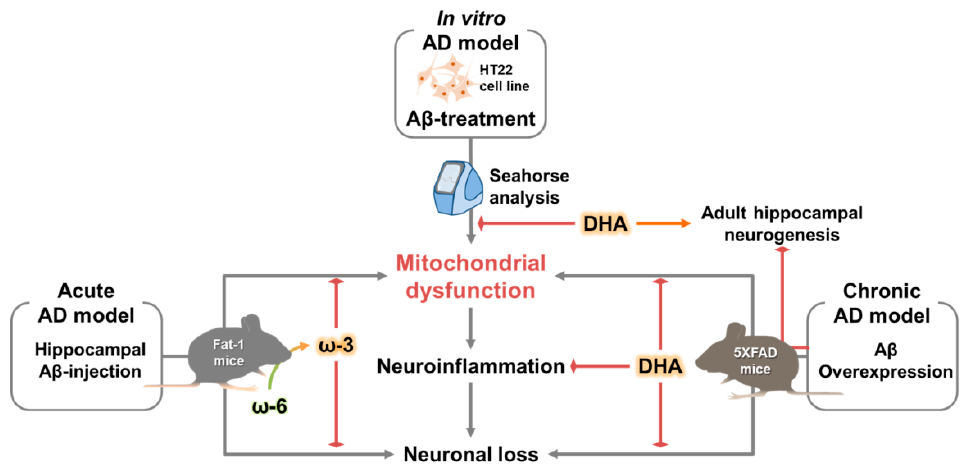
Figure 7. Schematic illustration of the effect of omega-3 fatty acid-type docosahexaenoic acid on AD-related pathology. Arrow-headed lines: stimulation, bar-headed lines: inhibition.